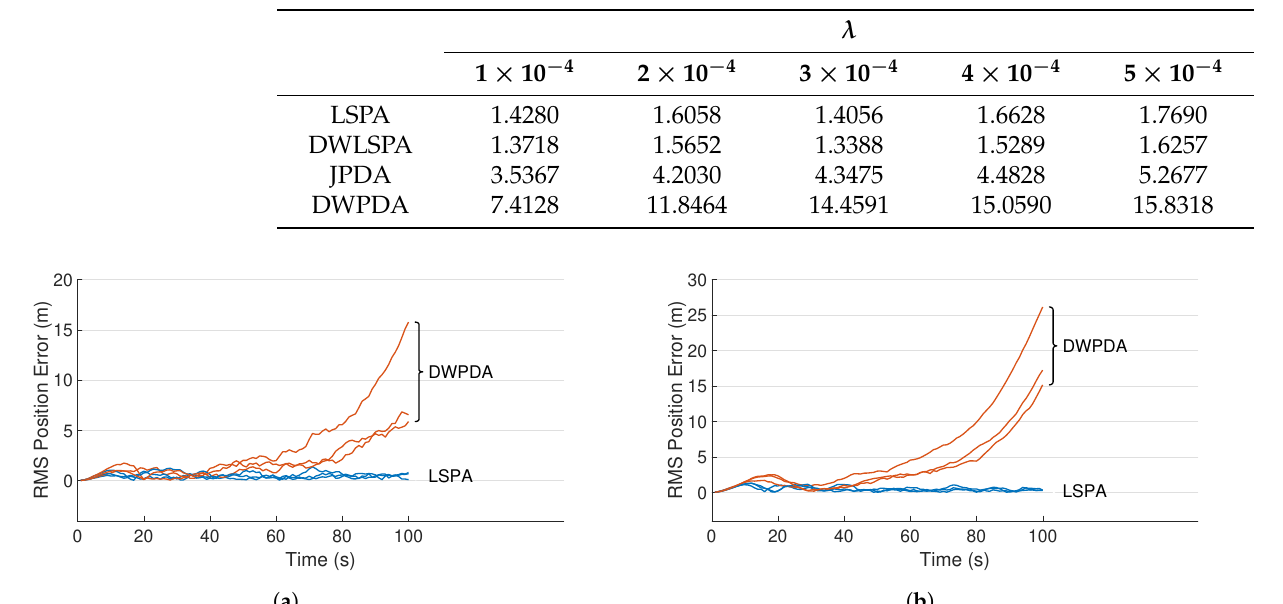
Table 2. Average GOSPA errors for tracking three targets with different clutter densities.